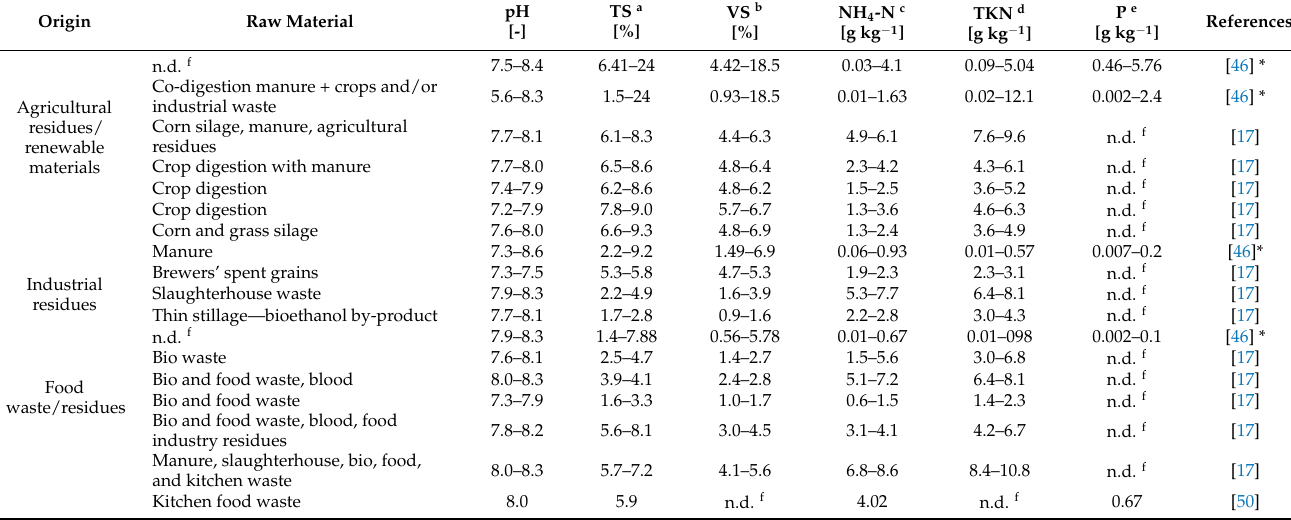
Table 2. Origin and composition of anaerobic